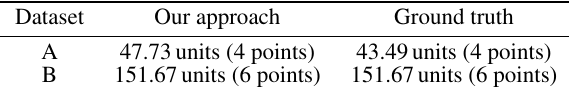
Table 2. The runtimes of both our approach and the ground truth generated by an exhaustive search of all valid